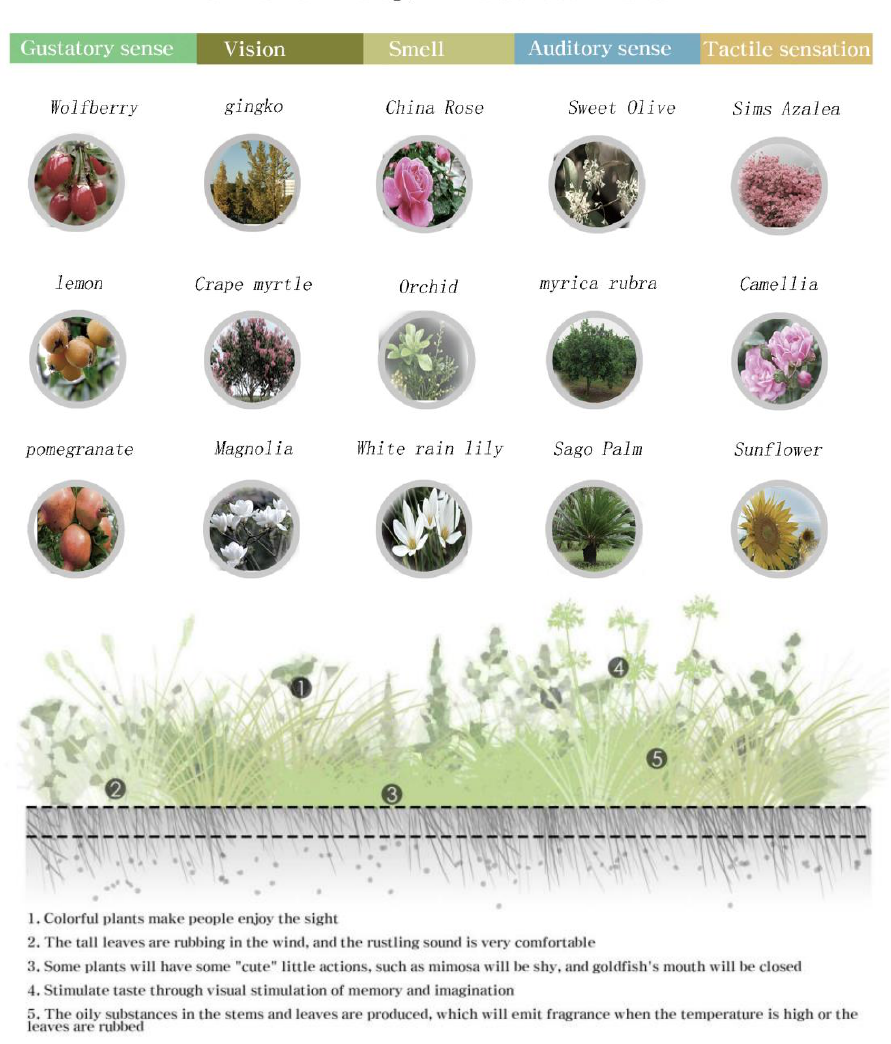
Figure 10. Multimodal configuration of plants .